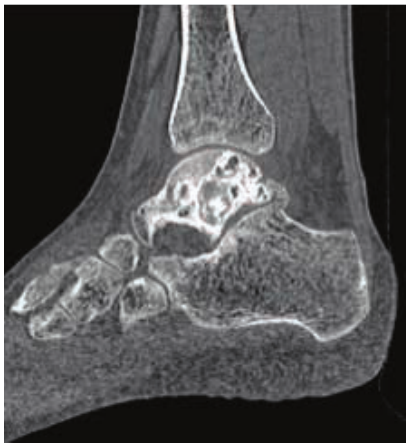
Figure 11: CT-scan of the talus at 5,5 months demonstrating further resorbtion of the CERAMENT and filling with new